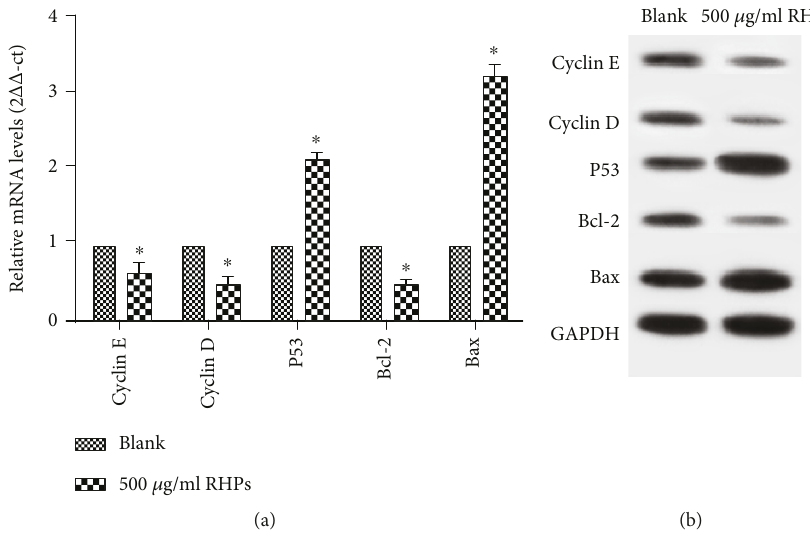
Figure 3: E ff ect of radix hedysari polysaccharide on cytokines in glioma cell lines. ∗ P < 0 05 , comparing the blank experimental groups.